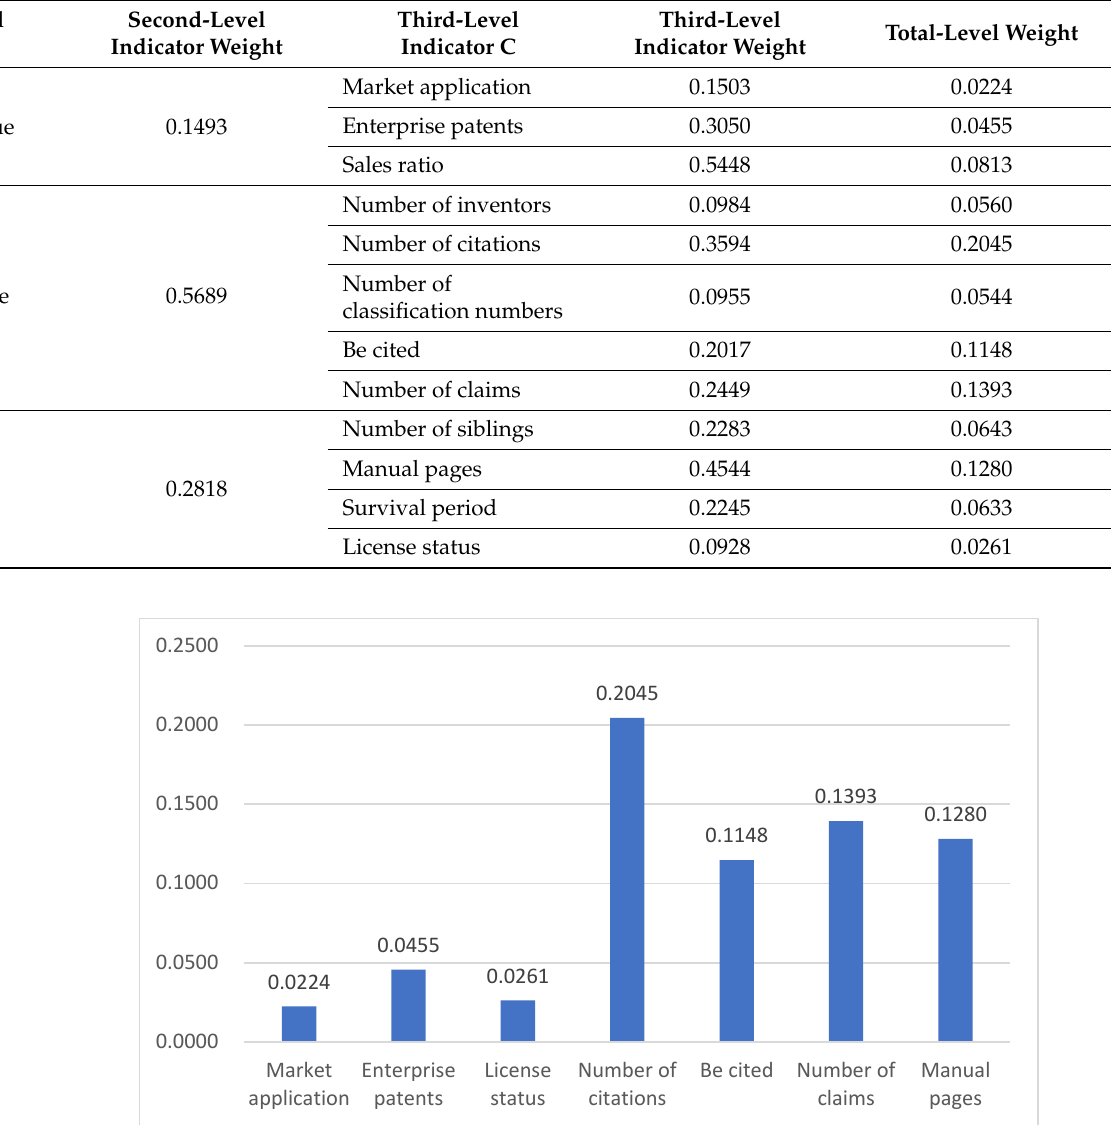
Table 13. Total-level weight of the evaluation attributes for core patents.